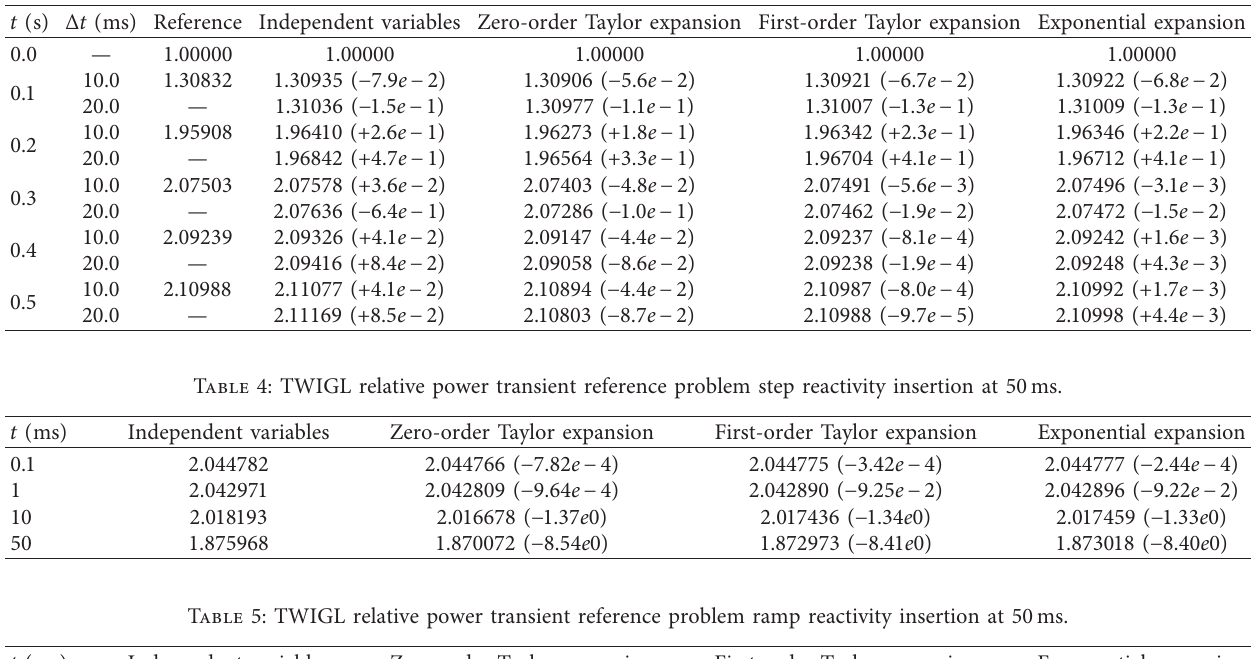
Table 3: Comparison of relative power (percentage error) between independent precursor methods and precursor elimination methods for ramp reactivity insertion.